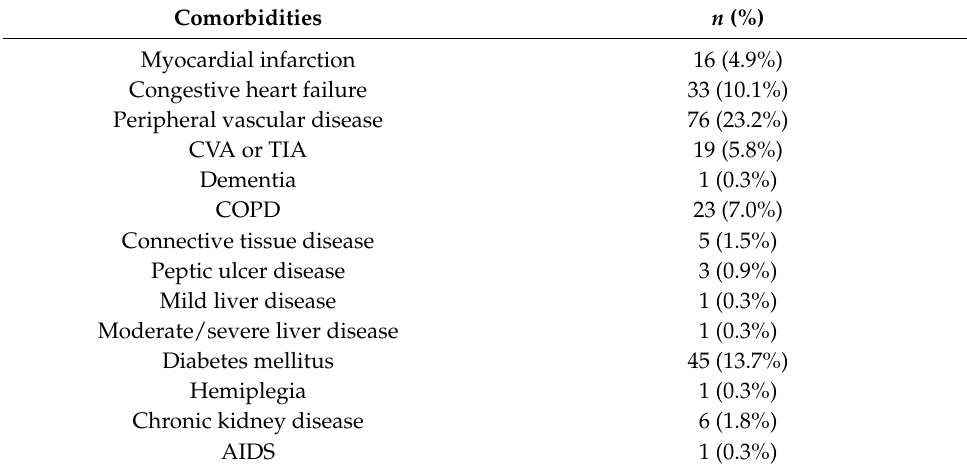
Table A2. Specification of the different comorbidities of the included patients ( n =